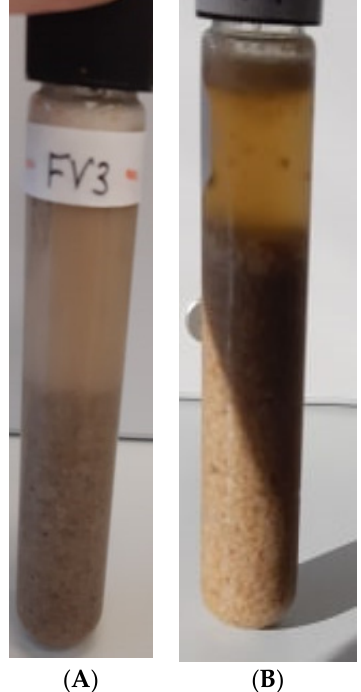
Figure A2. Mealworm meal at 3% ( w / v ) and pH 7.0 ( A ) before and ( B ) after heat treatment. Table A1. Probability values for the effects of insects (crickets and mealworms), treatments (meals, control hydrolysate and hydrolysate generated after HHP treatment of meals), concentration (0.5, 1.0 and 3.0% w / v ), pH (4.0, 5.5 and 7.0) and time (30, 60 and 90 min) on the emulsion stability index.